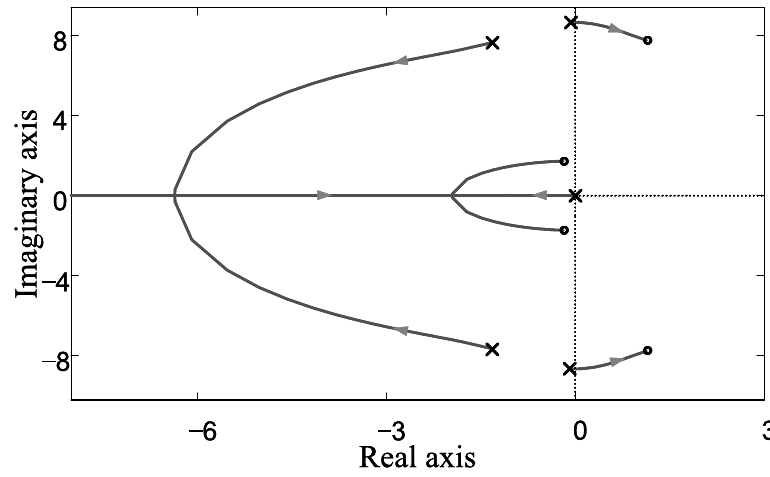
Figure 16. The root locus of D (s) following n 1 changes when n 2 = 0.001 V/var.